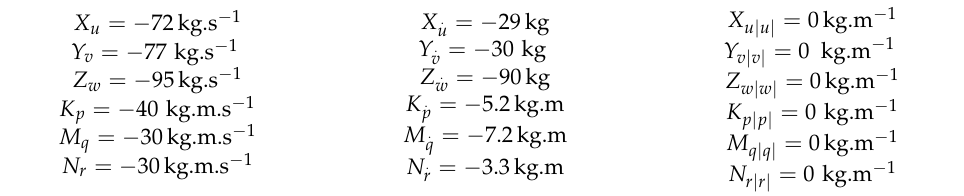
Table 2. The moments of inertia. 2 2 2 1.32 kg.m 2.08 kg.m 2.32 kg.m xx yy zz I I I